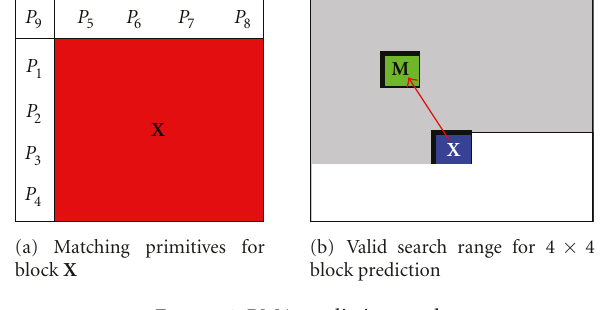
Figure 4: BMA prediction